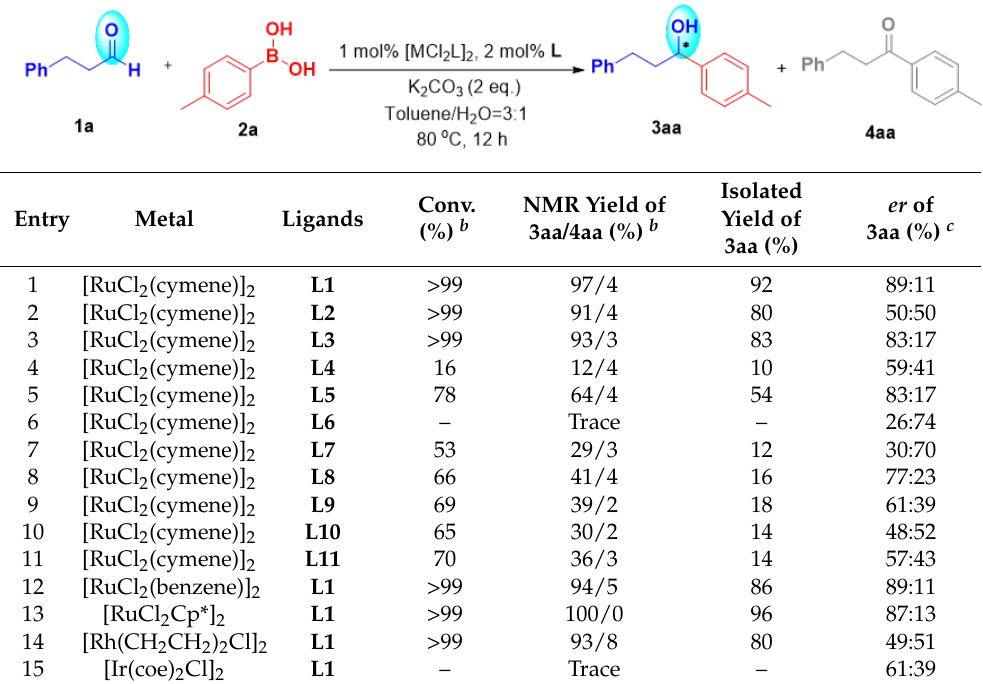
Table 1. Ligand and precursor screening of metal-catalyzed asymmetric additions of aliphatic aldehydes a .